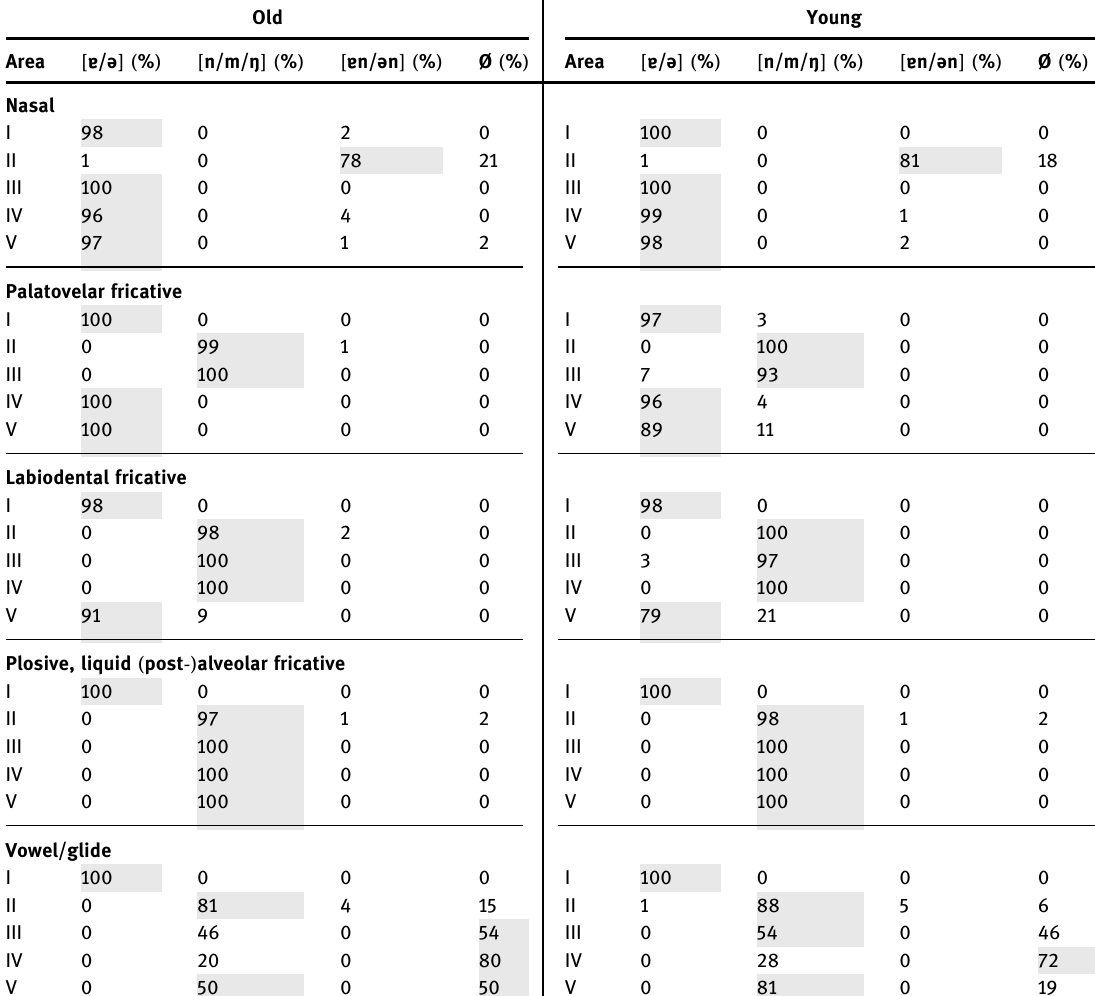
Table 3: Results for ( en ) in in fi